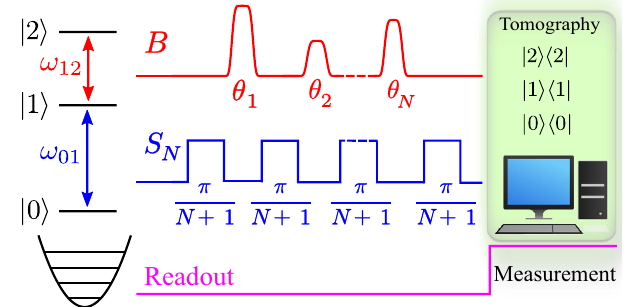
Fig. 1 | Coherent interaction-free detection. Schematic of the protocol, where S N and B microwave pulses are shown in blue and red, respectively, along with the probe pulse for readout.